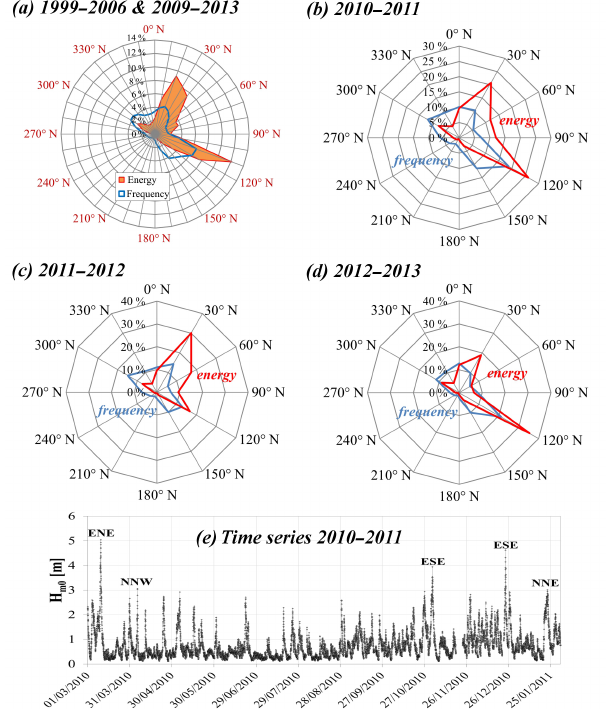
Figure 3. Wind roses of wave energy (red line) and frequency (blue line) referring to time periods: (a) 1999–2006 and 2009–2013, (b) 2010–2011, (c) 2011–2012 and (d) 2012–2013. (e) Time series of the significant heights measured between March 2010 and Jan- uary 2011, with indications of the largest wave ( H m0 > 3m) direc-